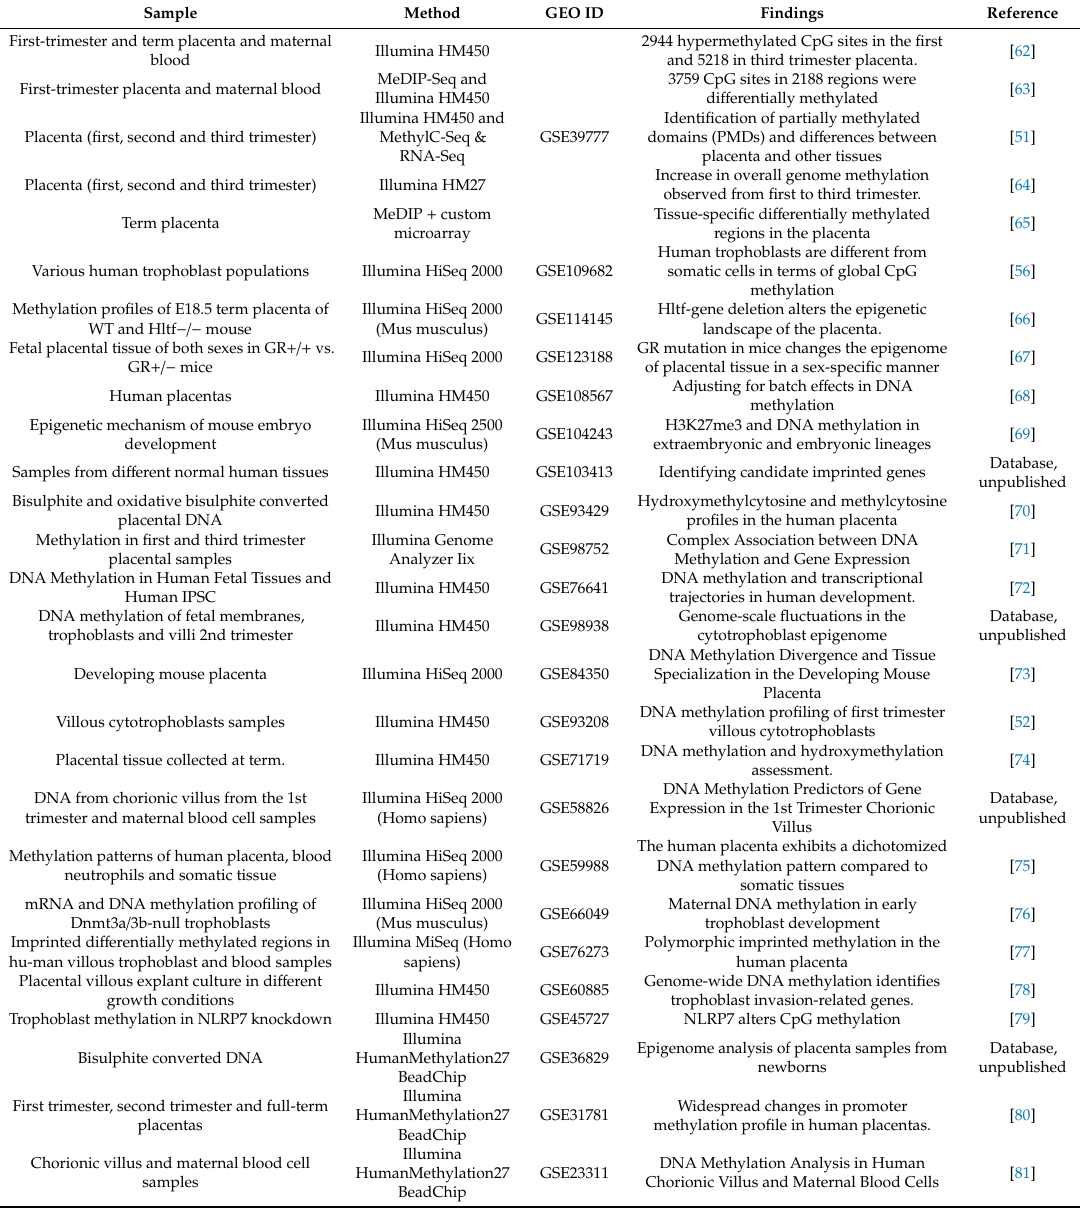
Table 2. Summary of DNA methylation studies in developing placenta using genome-wide